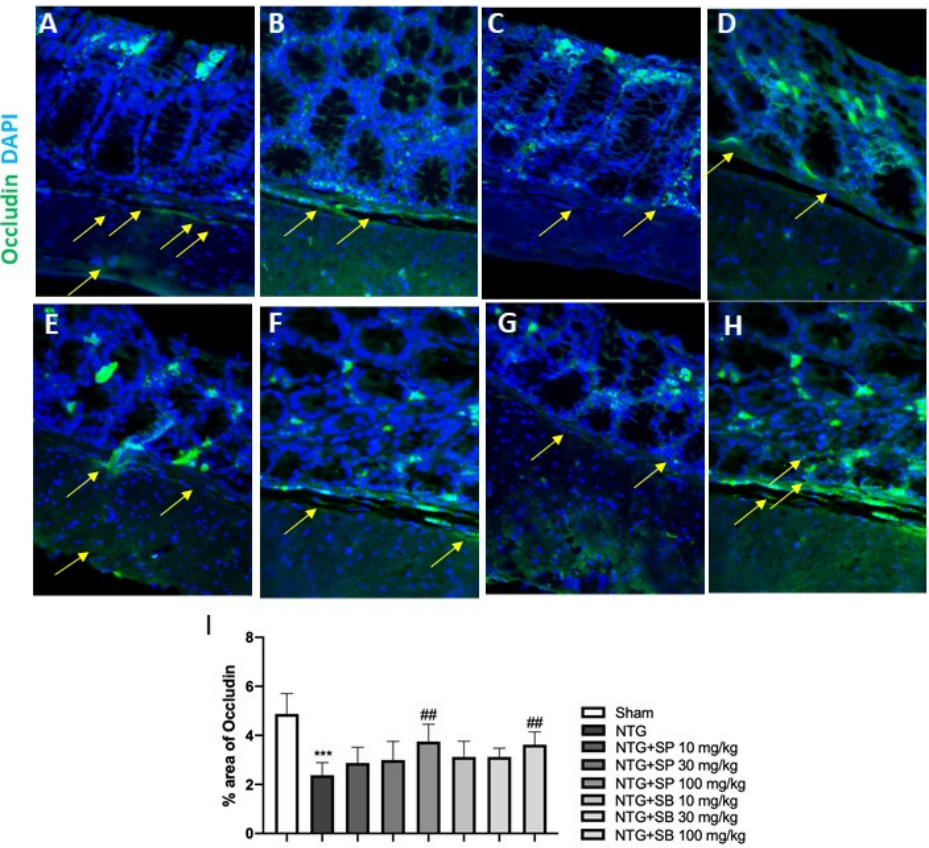
Figure 5. SCFAs treatment restores occludin expression. Immunofluorescence staining revealed that NTG group was characterized by a decrease of occludin expression ( B ) compared to sham group ( A ), however SCFAs treatment ( E , H ) significantly restored occludin expression. No significant difference was observed in SP- and SB-treated-mice at the lower dose of 10 mg/kg ( C,D,F , G ). The yellow arrows indicated positive cells. ( I ) *** p < 0.001 vs. sham; ## p < 0.01 vs. NTG.